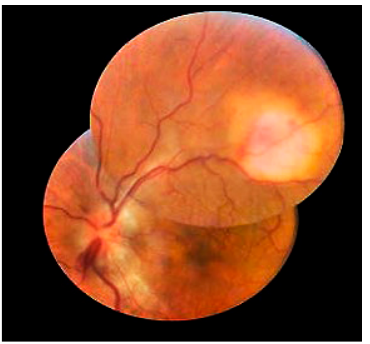
Figure 2. Fundus photograph of the left eye at presentation showing a chorioretinal granuloma, papilledema, retinal vasculitis, and minimal vitritis. (Adapted with permission from Ref [64] . 2014, Erik Schaftenaar et